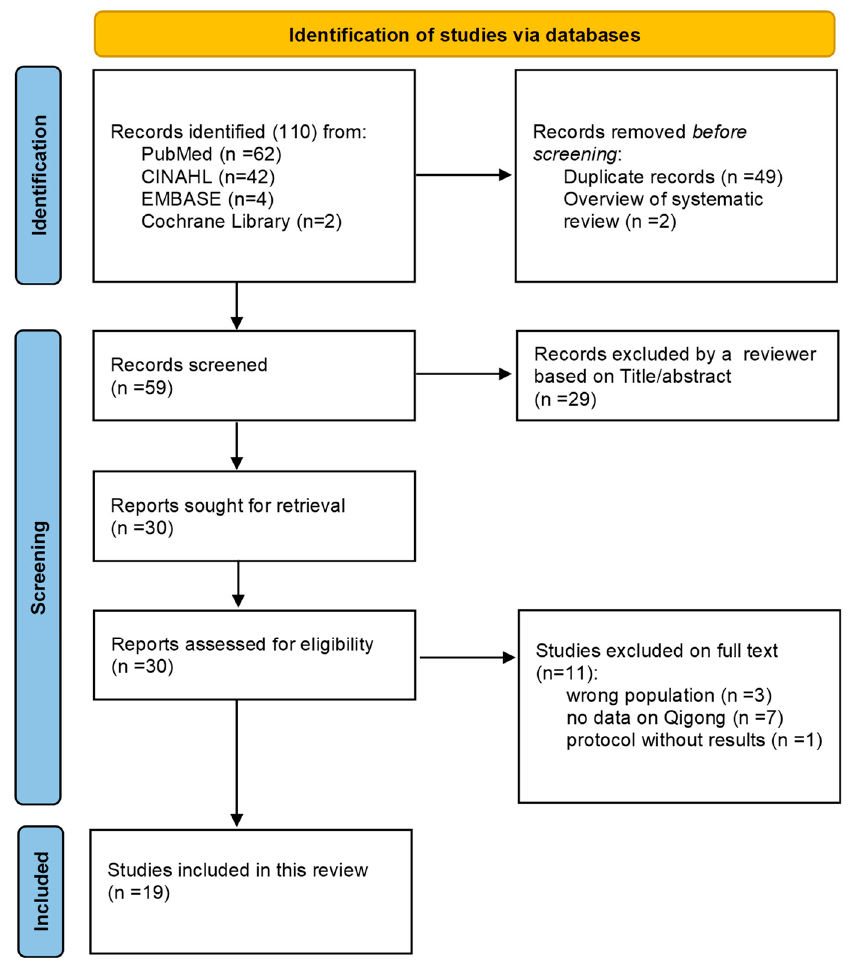
Figure 1. PRISMA flow chart describing the selection of included publications.